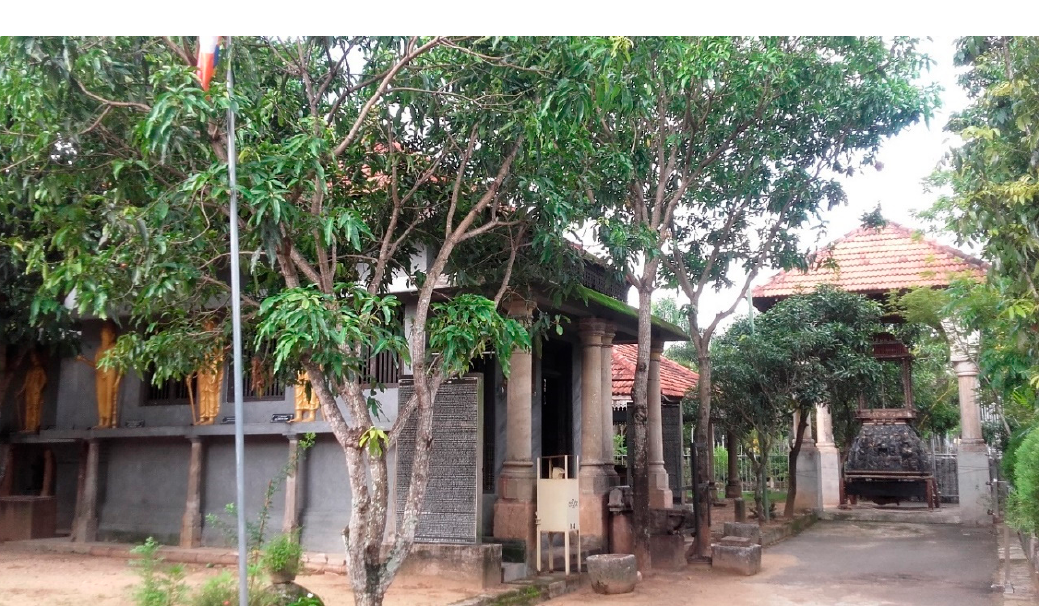
Figure 1. The Sri Lankesvara maha Ravana raja mandiraya (left side). This building is located at the premises of the Sri Devram Maha Viharaya. On the right side: one of the chariots for Ravana. This chariot is taken around in the annual perahera organized by this Buddhist temple. Picture taken by author, 6 June 2017.